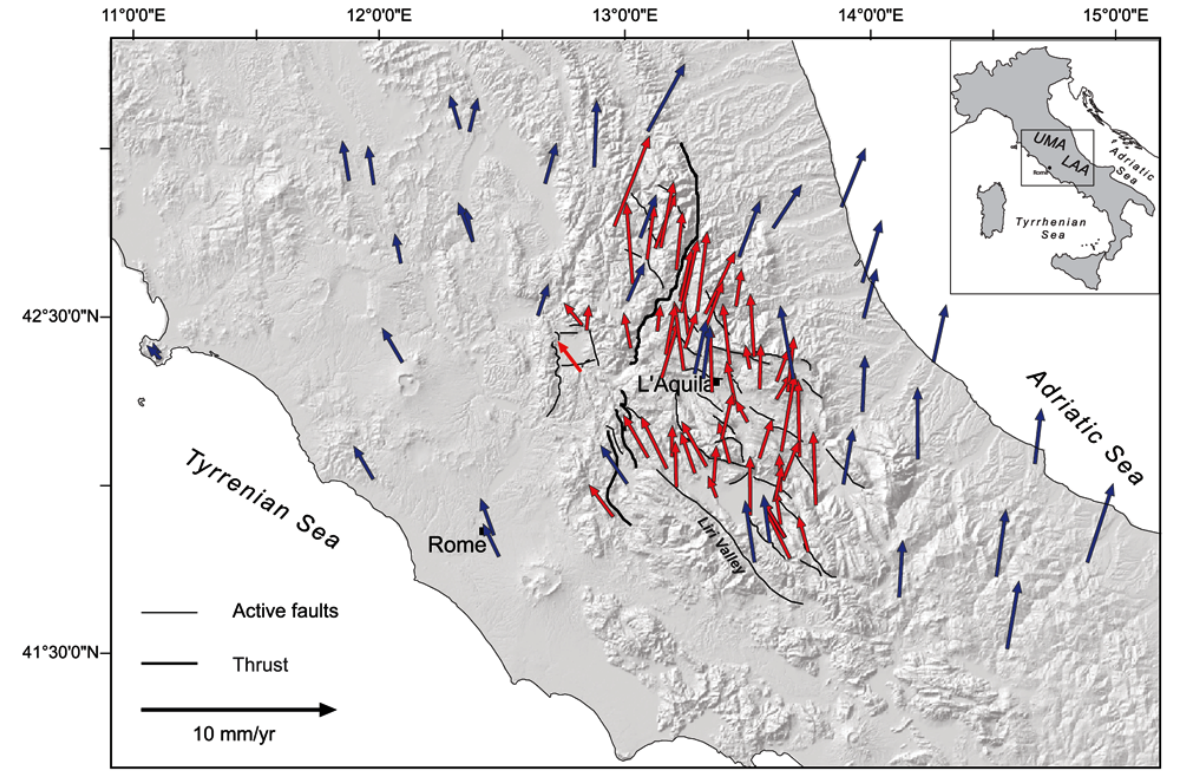
Figure 4. GPS combined velocity fields estimated for the time span from 1999 to 2007 with respect to the Eurasian plate. Red arrows, Central Apennines Geodetic Network GPS velocities; blue arrows, continuous GPS velocities. Inset: Location of the study region within Italy. UMA, Umbria-Marche Apennines; LAA, Lazio-Abruzzo